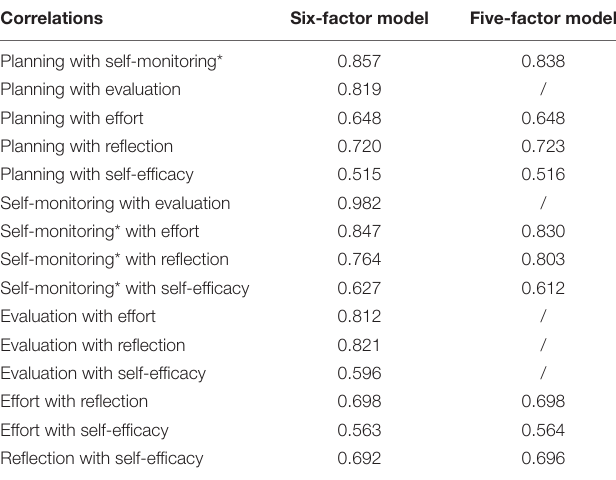
TABLE 3 | Correlations between factors in the six-factor and five-factor models.